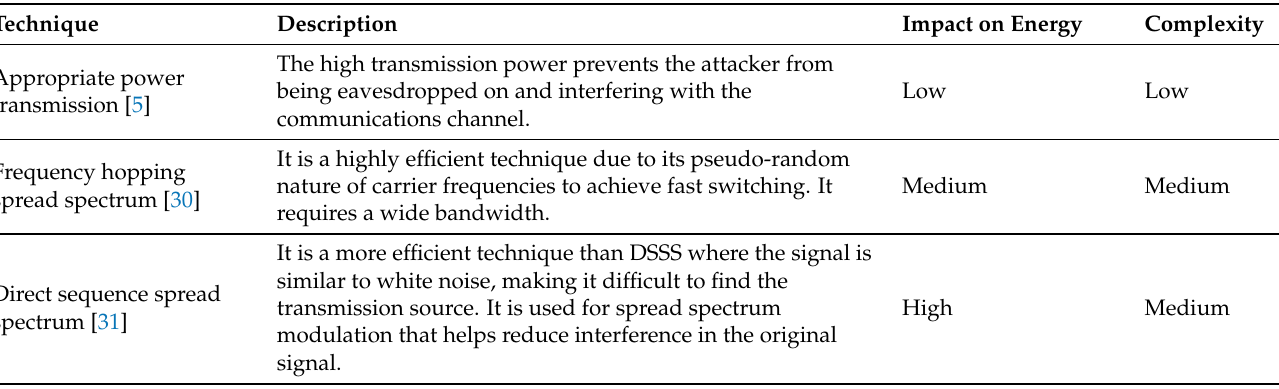
Table 1. Techniques to mitigate jamming